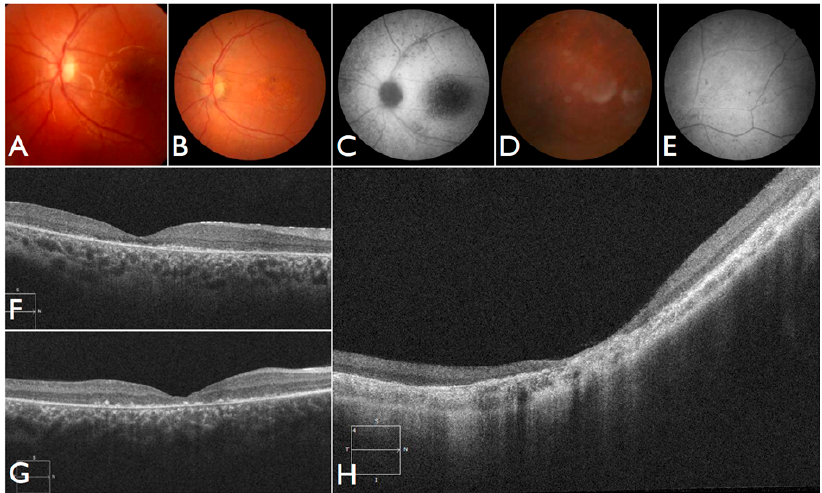
Figure 6. Fundus and OCT images for four individuals solved by pathogenic variants in ABCA4 . ( A – E ) Fundus and autofluorescence images of FBP_1; ( F ) OCT image ofFBP_61. ( G ) OCT image of FBP_65. ( H ) OCT image of FBP_9.